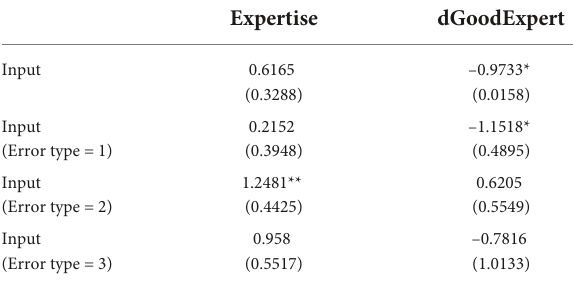
TABLE 4 Effect of expertise on the type of error answered, when Answer =